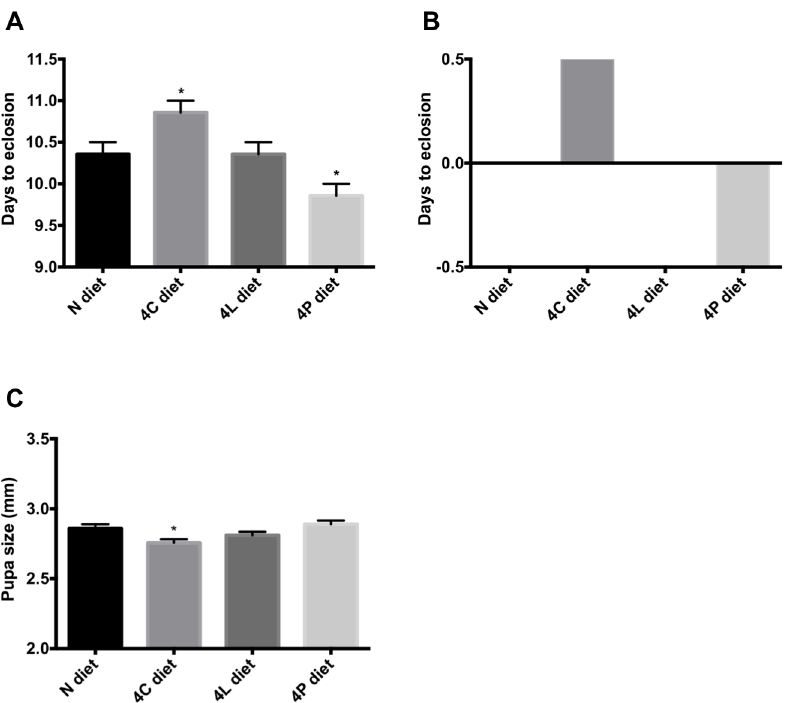
Fig 3. Effect of enriched diets on times to eclosion and larval size. (A) The duration (in days) from egg laying to eclosion of adult flies on the indicated diets. 7 independent experiments (totaling (cid:1) 230 animals per experimental condition) were performed. (B) The mean values in (A) were subtracted from the mean duration measured on the N diet. (C) Flies ( n = 54 per condition) grown on the different diets were allowed to develop until pupa stages, at which time a caliper was used to measure their body length. Asterisks indicate significant differences (P < 0.05) for Ordinary one-way ANOVA. Error bars, standard error of the mean.